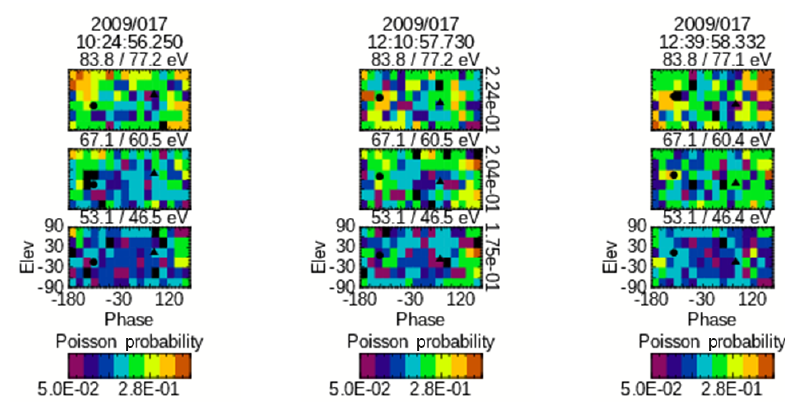
Figure 7. φ – θ plots of the Poisson statistics associated with the top three energy steps in each of the three columns in Fig. 5.